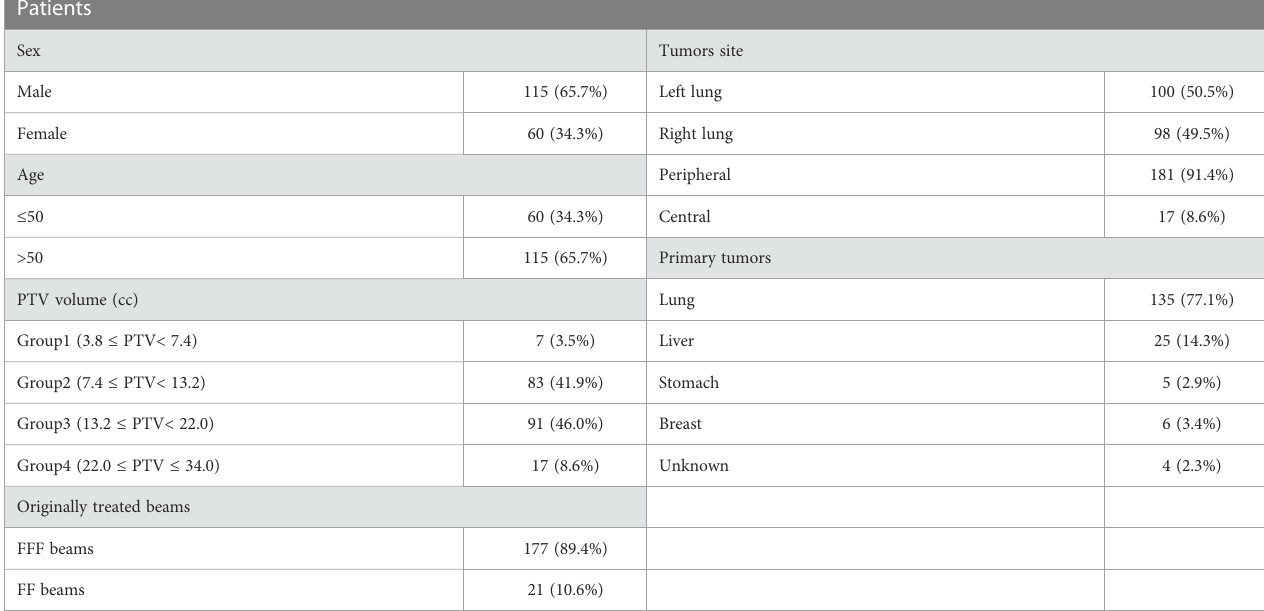
TABLE 1 Patient characteristics of 175 patients with 198 pulmonary